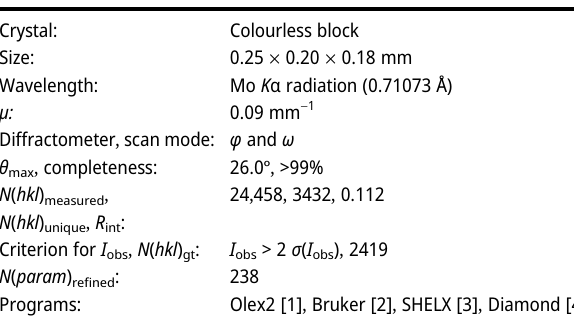
Table  : Data collection and